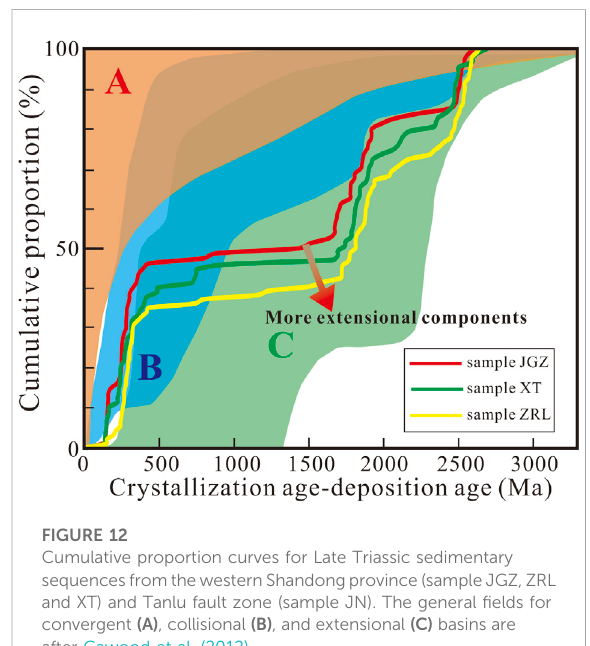
FIGURE 12 Cumulative proportion curves for Late Triassic sedimentary sequencesfromthewesternShandongprovince(sampleJGZ,ZRL and XT) and Tanlu fault zone (sample JN). The general fi elds for convergent (A) , collisional (B) , and extensional (C) basins are after Cawood et al.